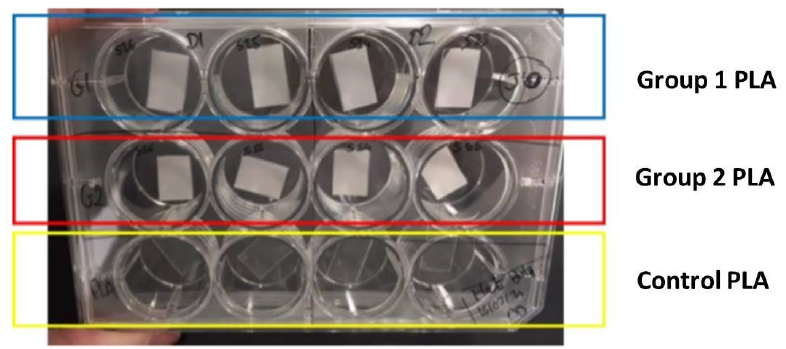
Figure 3. Preparation procedure of cell culture studies.